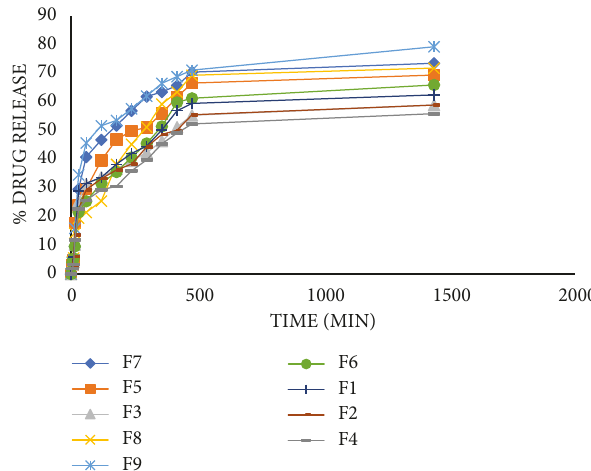
Figure 4: In vitro drug release profile of SLNs formulation.